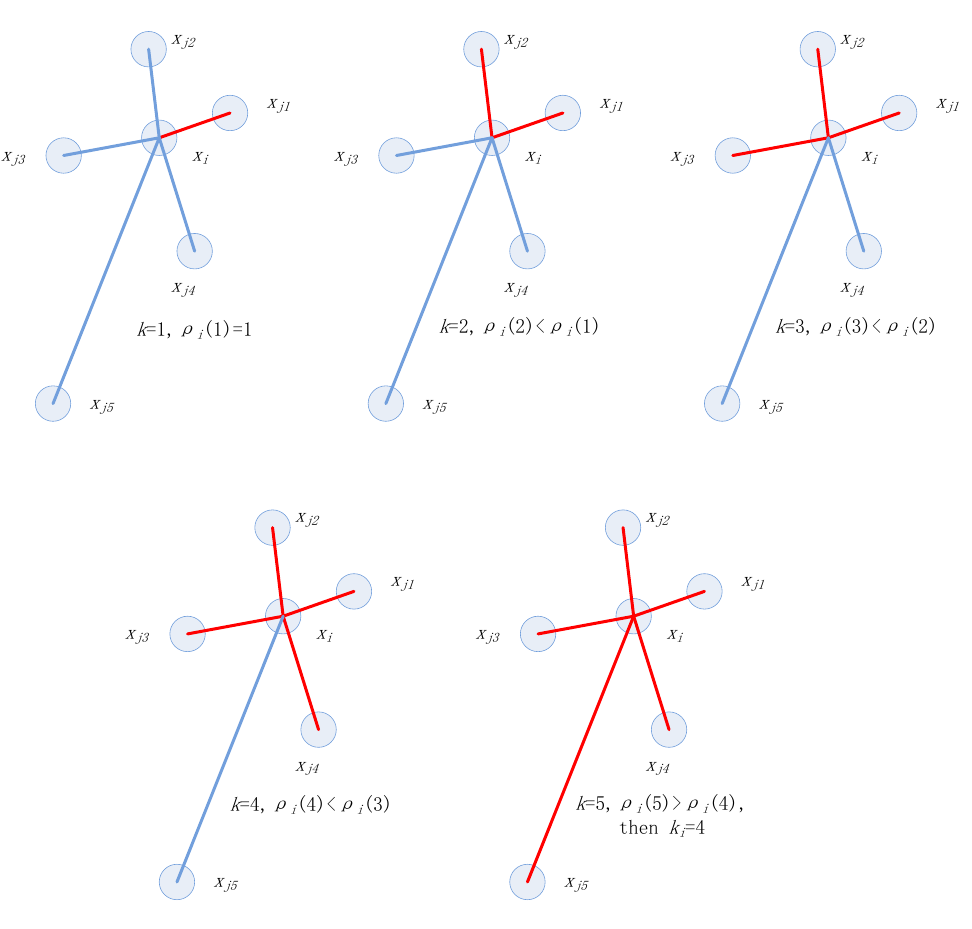
Figure 1. The variation of data density with different choices of parameter k.